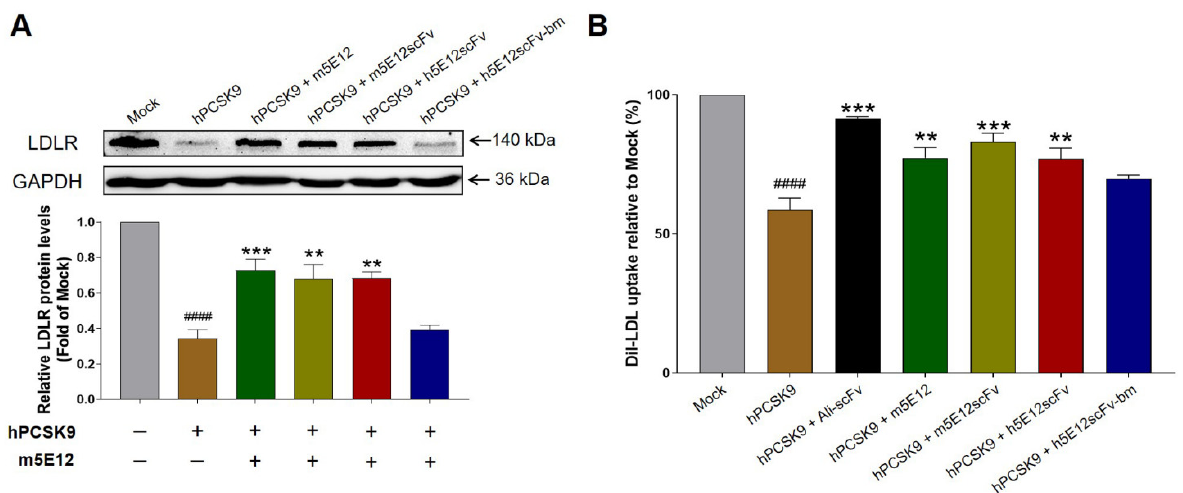
Figure 4. Selection of humanized 5E12 scFv. ( A ) Inhibitory effect of humanized 5E12scFv on PCSK9-mediated LDLR degradation as assessed by Western blot analysis. HepG2 cells were treated with 20 µ g/mL PCSK9 alone or co-treated with 50 µ g/mL m5E12 for 12 h, then the protein levels of LDLR were determined by Western blot. The changes of LDLR were calculated relative to that of the Mock group (vehicle control) after calibration with GAPDH in each lane. ( B ) Effect of humanized 5E12 scFv on PCSK9-mediated inhibition of LDL-C uptake in HepG2 cells. #### p < 0.0001 vs. Mock group; ** p < 0.01, *** p < 0.001 vs. hPCSK9 group. Data are means ± SEM of 3 independent experiments.